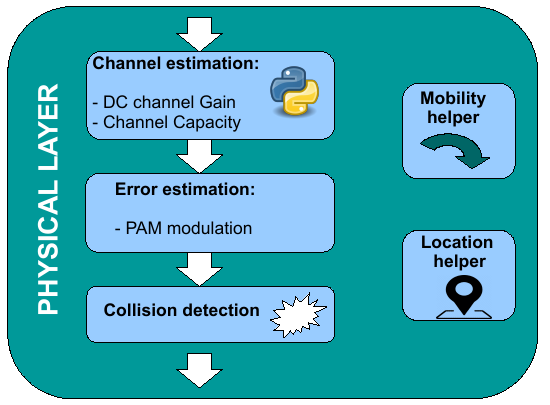
Figure 12. Physical layer